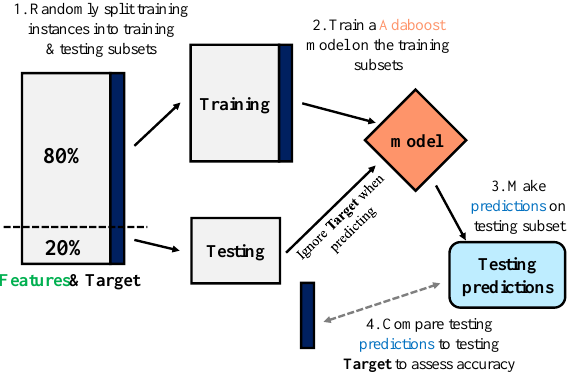
Figure 3. The AdaBoost model building process.